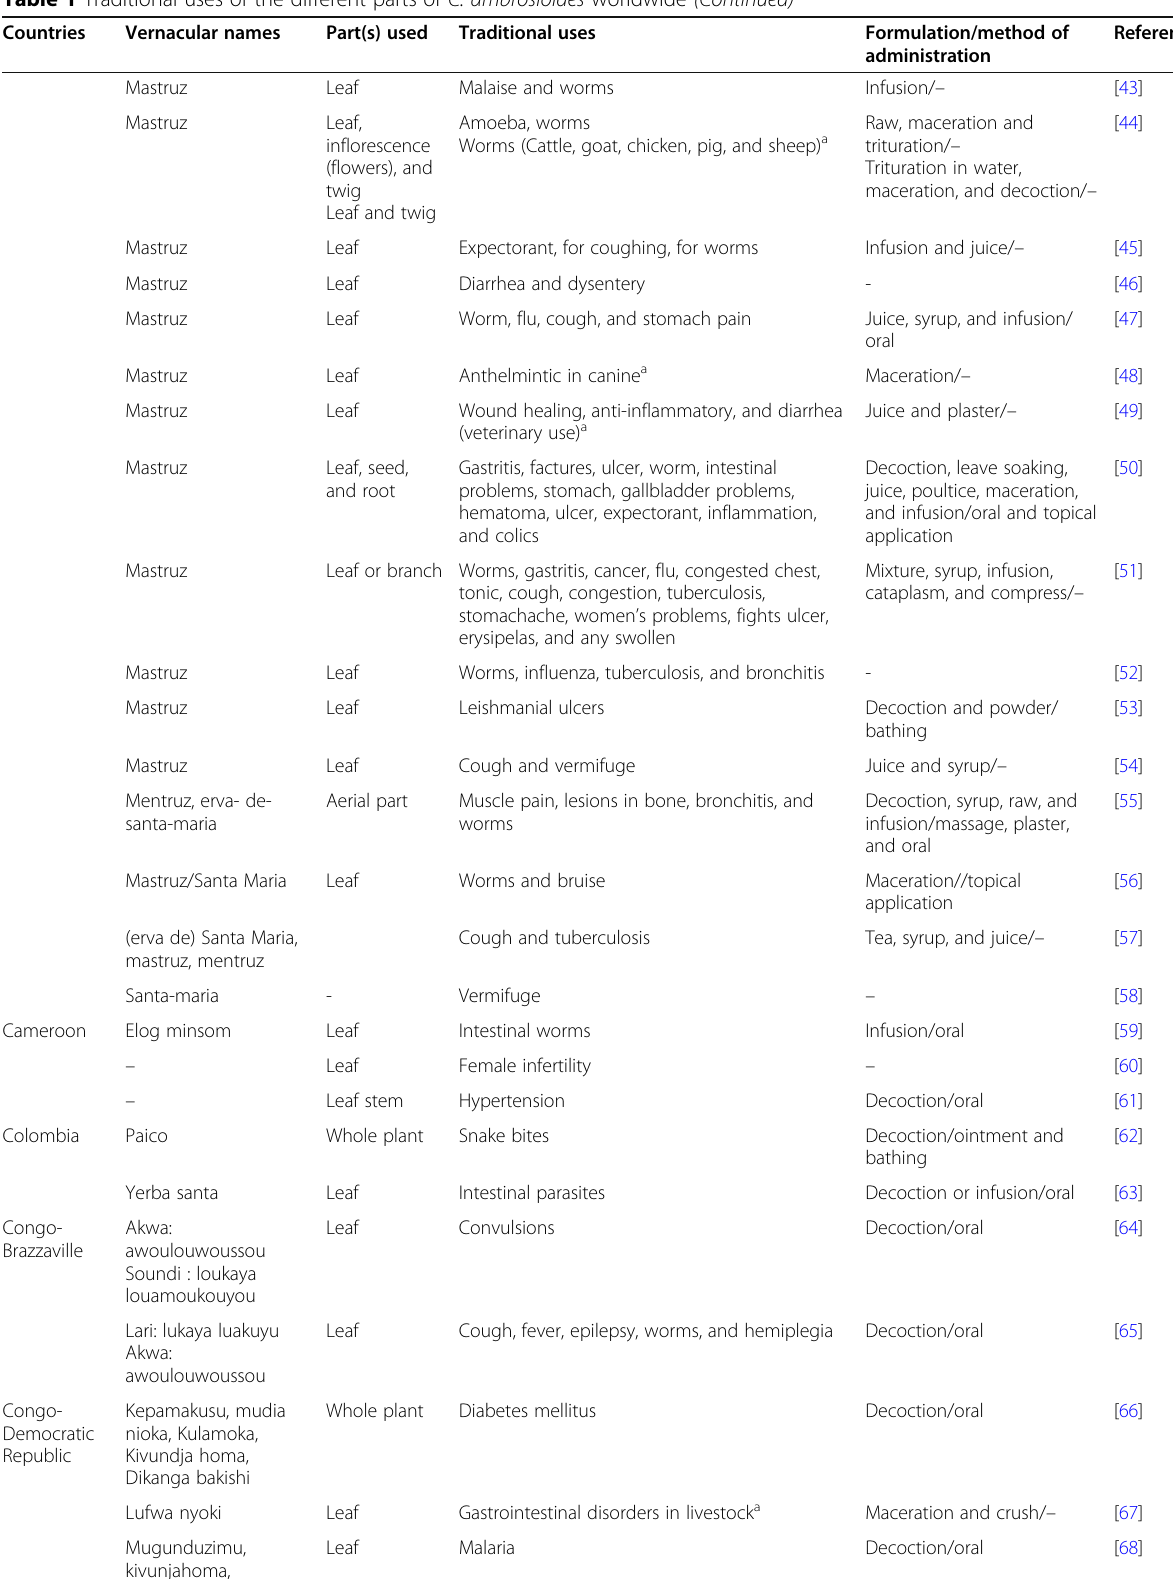
Table 1 Traditional uses of the different parts of C. ambrosioides worldwide (Continued)